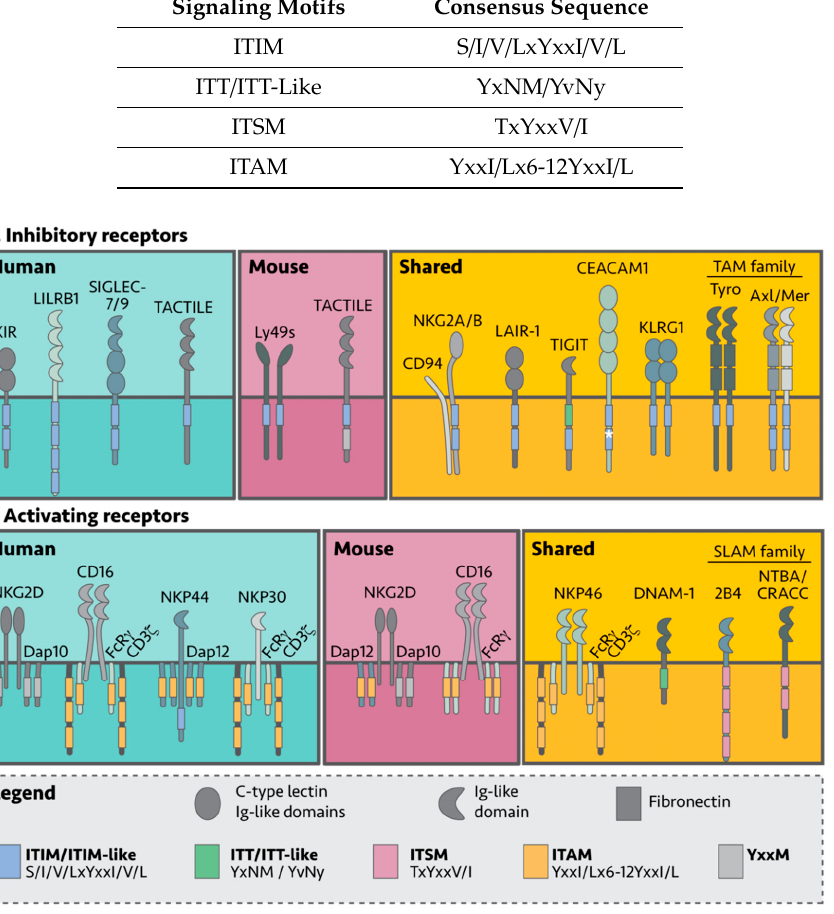
Figure 2. NK cell surface receptors involved in tumor recognition. NK cells express a myriad of inhibitory and activating receptors designed to recognize healthy or aberrant (non-healthy) cells. ( A ) Inhibitory receptors dampen activating NK cell signals via cytoplasmic tyrosine motifs in their cytoplasmic tails, regulating NK cell effector function. ( B ) In contrast, most activating receptors signal through cytoplasmic adaptor proteins. Although many of the receptors are expressed by both mouse and human NK cells (shared), some are exclusive.